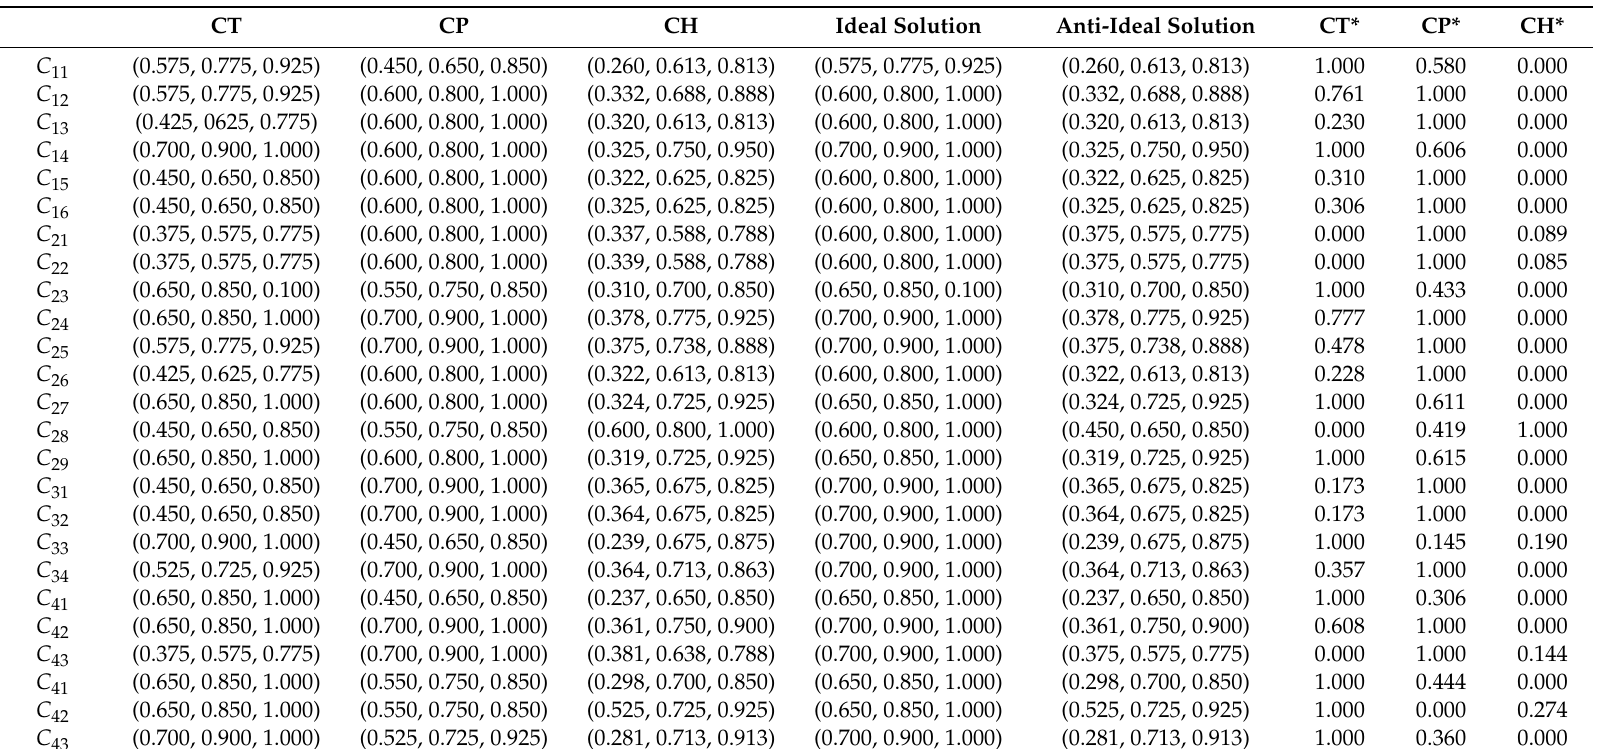
Table 4. The average ratings, and the ideal and anti-ideal solutions by